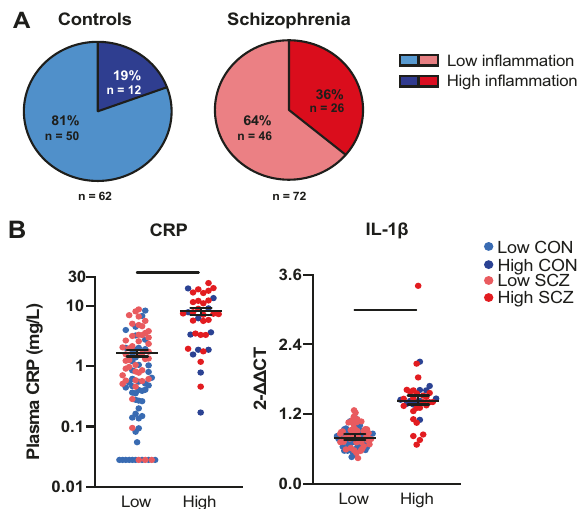
Fig. 3 High and low in fl ammation subgroups. A Proportions of control and patient samples that were classi fi ed via recursive two- step cluster analysis as having high and low in fl ammation, based on plasma levels of CRP and peripheral blood leukocyte expression of IL-1 β mRNA. B Plasma CRP and IL-1 β mRNA in high and low in fl ammation biotypes (median + 95% con fi dence interval). *** p <